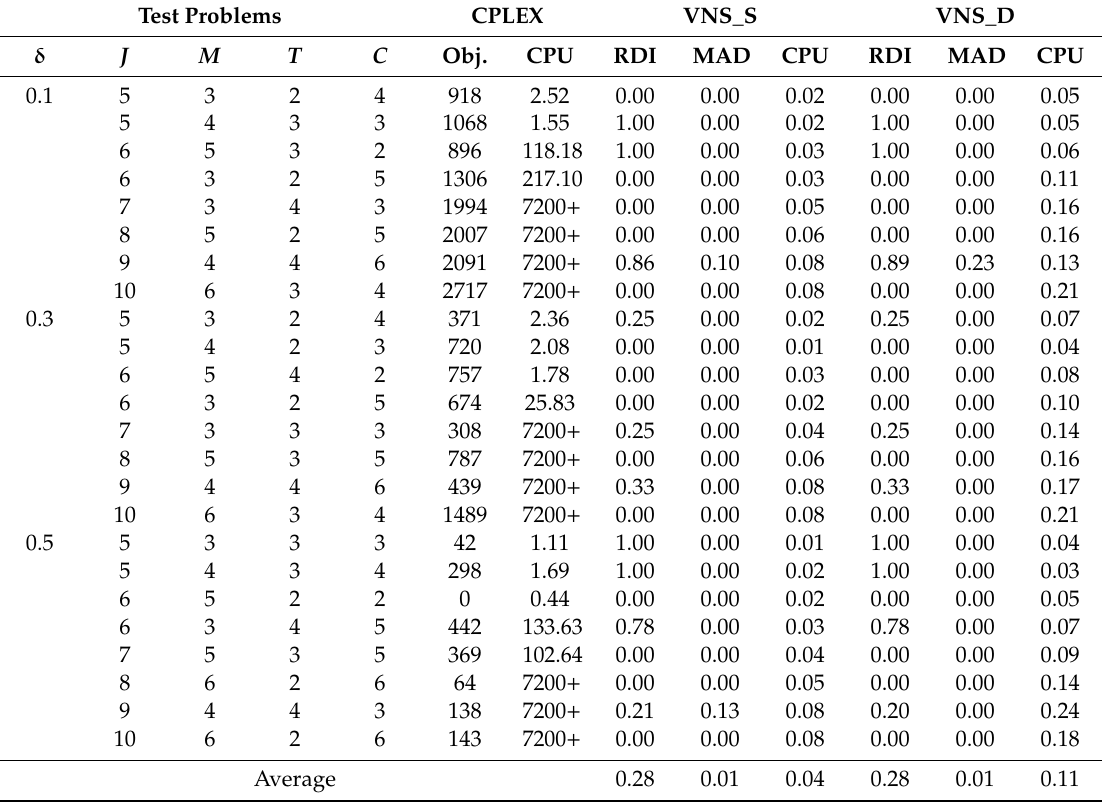
Table 4. Test results of small-sized